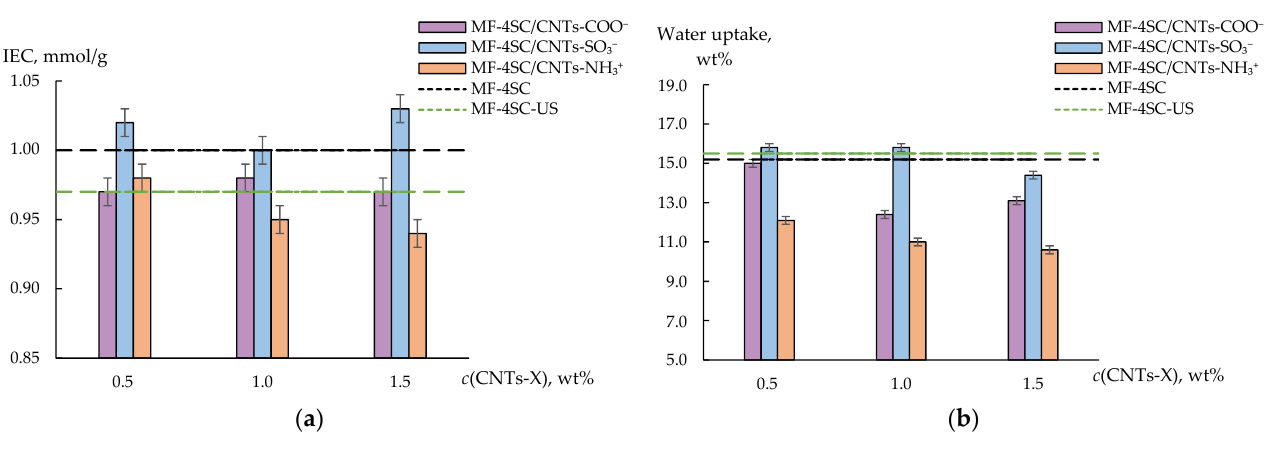
Figure 7. IEC (mmol/g) of the membranes ( a ) and water uptake (wt%) of the membranes in the K + -form in contact with water ( b ). The confidence intervals in the evaluation of the IEC and water uptake were ± 0.01 mmol/g and ± 0.2%, respectively, in the case of MF-4SC membrane, and ± 0.01 mmol/g and ± 0.1%, respectively, in the case of MF-4SC-US membrane.